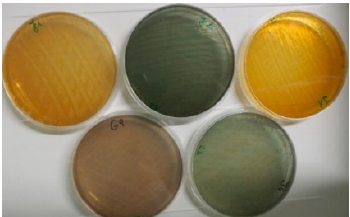
Figure 2. Colony morphology (pigmentation) of five P. aeruginosa strains belonging to the same MLVA type. All 54 isolates (32 from milk, 11 from the teat cleaning solution and eleven from the udder wipes) were identified as P. aeruginosa by MALDI-TOF MS. All score levels ranged between 2.11 and 2.45, indicating a reliable species identification. The species-specific PCR yielded an amplicon of the expected size (391 bp). With the various applied methods (ERIC-, REP-, BOX and RAPD-PCR, MLVA) all 54 isolates were indistinguishable. Resampling of cows during the following herd visits confirmed IMI with P.